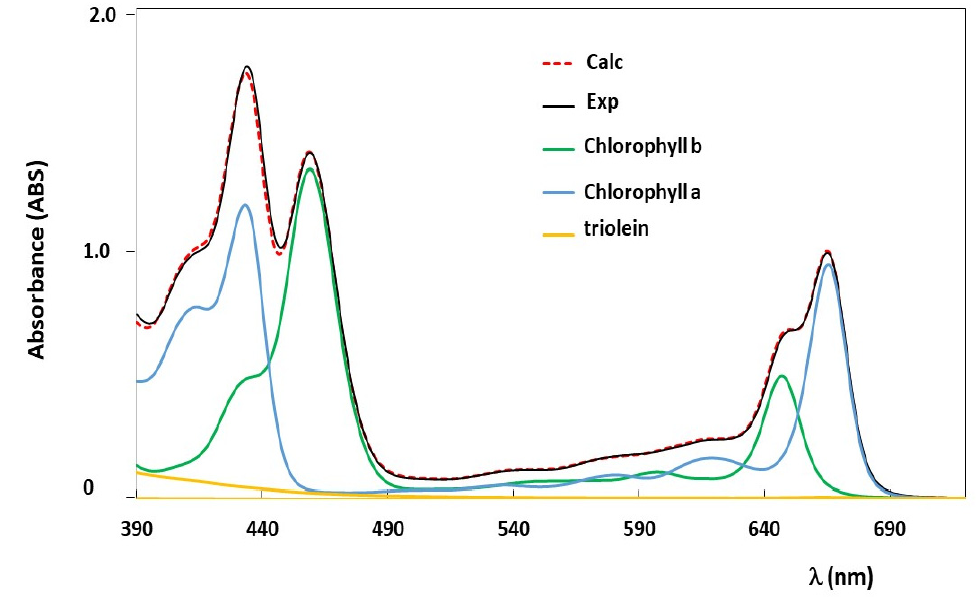
Figure 3. Experimental (Exp) and theoretical (Calc) UV-vis absorption spectra of a test sample oil. Wavelengths are reported in nm. The optical length was of 0.5 cm. Single pigments’